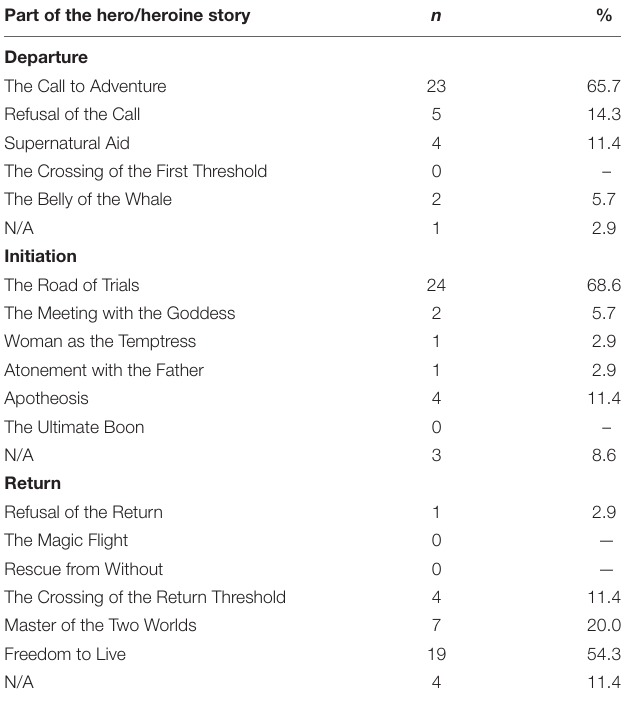
TABLE 4 | Percentage of participants according to the main tendencies in each part of the hero/heroine story. Part of the hero/heroine